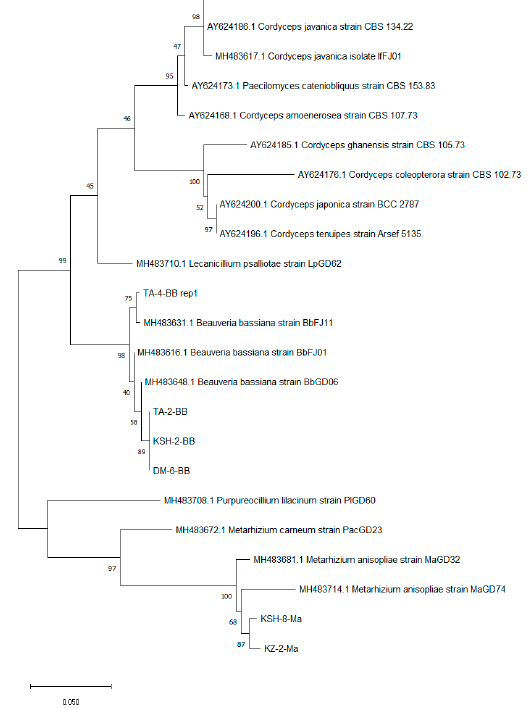
Figure 3. Molecular phylogeny analysis of selected entomopathogenic fungi based on molecular characteristics of ITS region in fungal DNA. The tree was inferred using the maximum likelihood method and Jukes–Cantor model in MEGA11. The percentage of trees in which the associated taxa clustered together is shown next to the branches. Initial trees for the heuristic search were obtained automatically by applying the neighbor-joining and BioNJ algorithms to a matrix of pairwise distances estimated using the Jukes–Cantor model, and then selecting the topology with superior log likelihood value. The tree is drawn to scale, with branch lengths measured in the number of substitutions per site. All positions containing gaps and missing data were eliminated and there was a total of 420 positions in the final dataset.